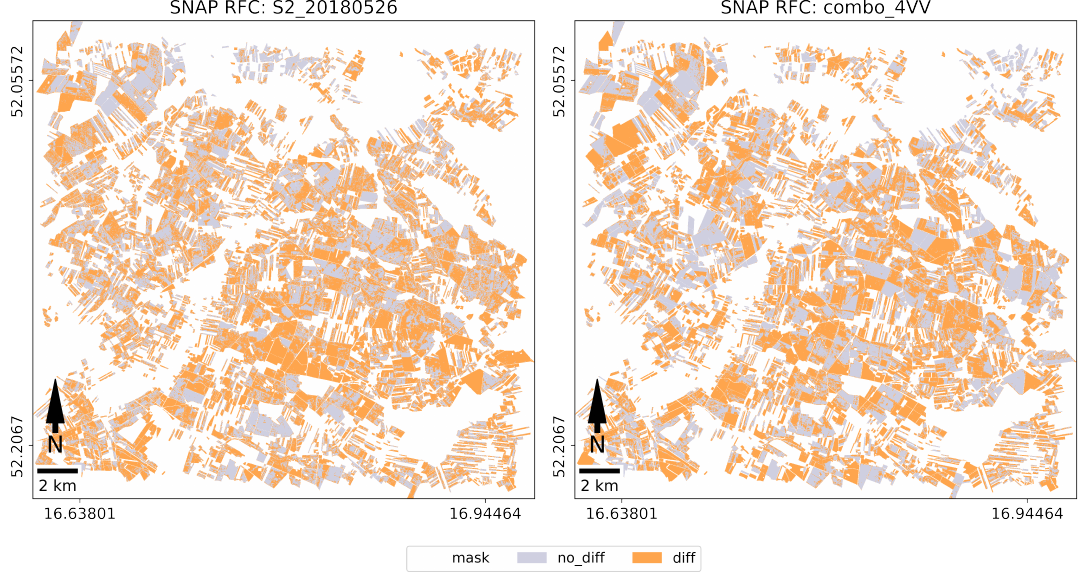
Figure 7. Map of discrepancies between farmers’ declarations and classification results (UTM34N coordinate). RF classification—sampling 50,000 pixels. Confirmation in gray, difference between declared and classified